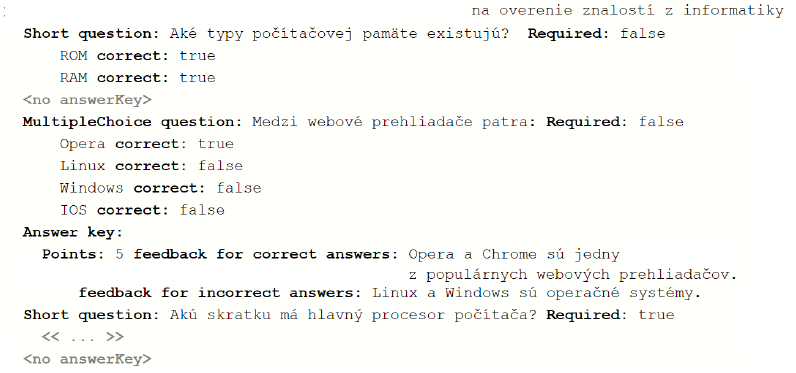
Figure 4. Example quiz in the MPS-based